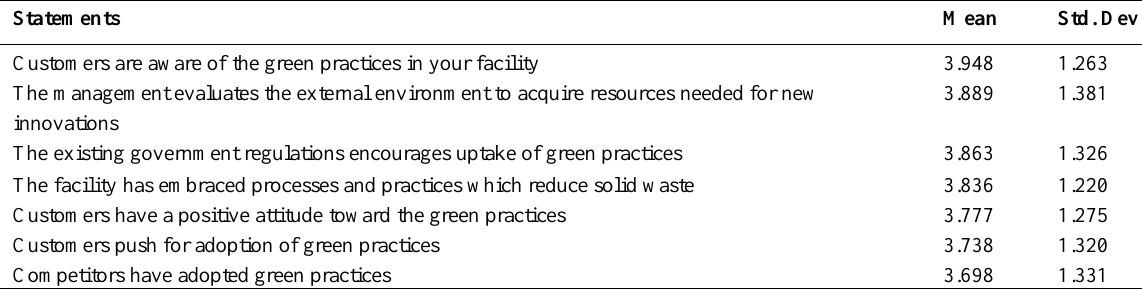
Table 1: Environmental Awareness in Lodges and Tented Camps